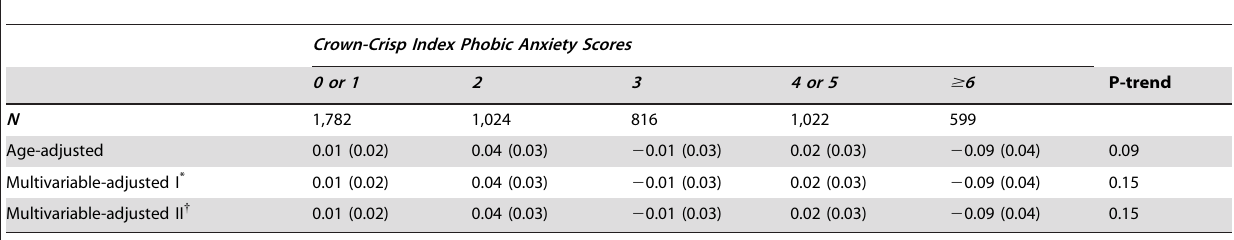
Table 2. Least-squares mean leukocyte telomere length z-scores (standard errors), by phobic anxiety